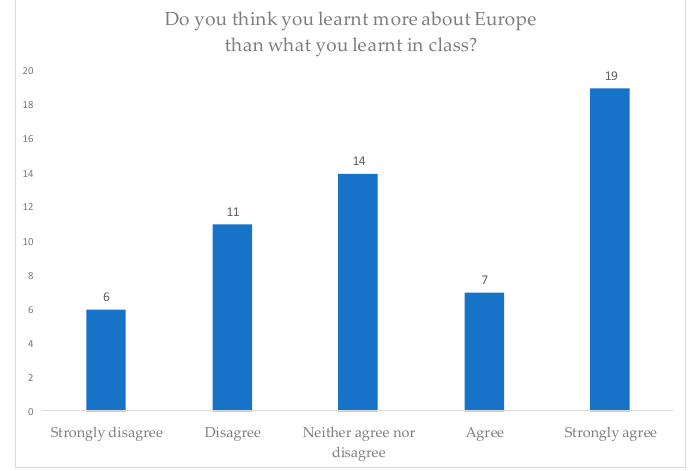
Figure 11. Self-reported comparison between conventional and Game-Based Learning (GBL).